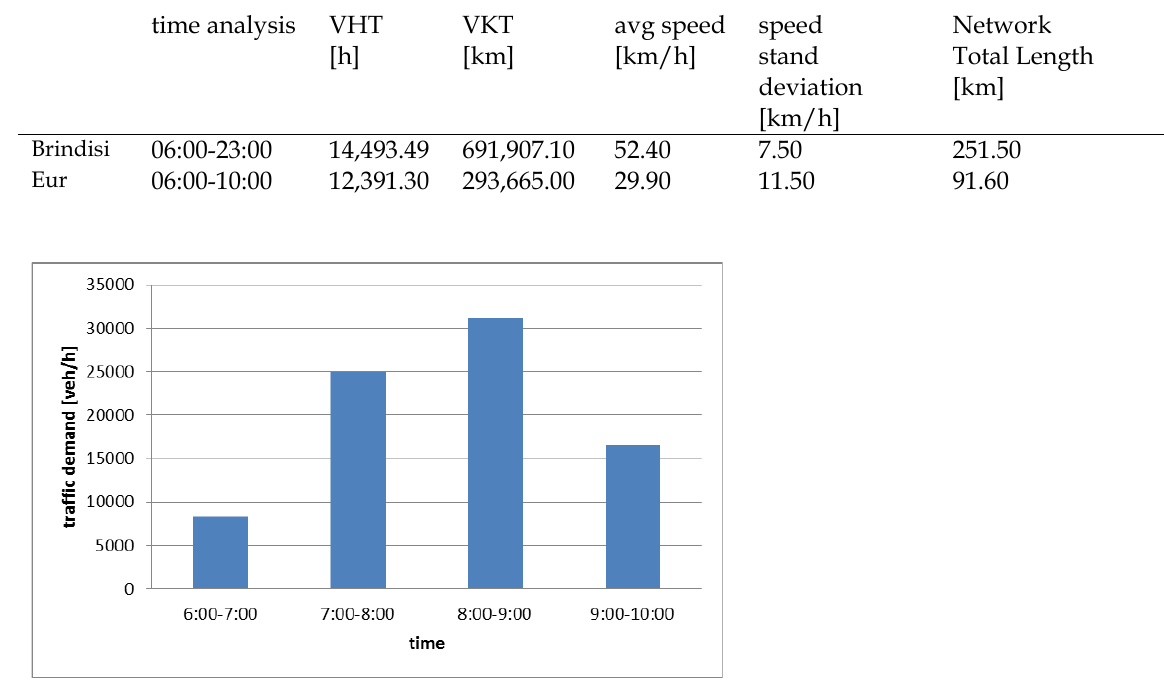
Figure 7. The demand profile for the “Eur”